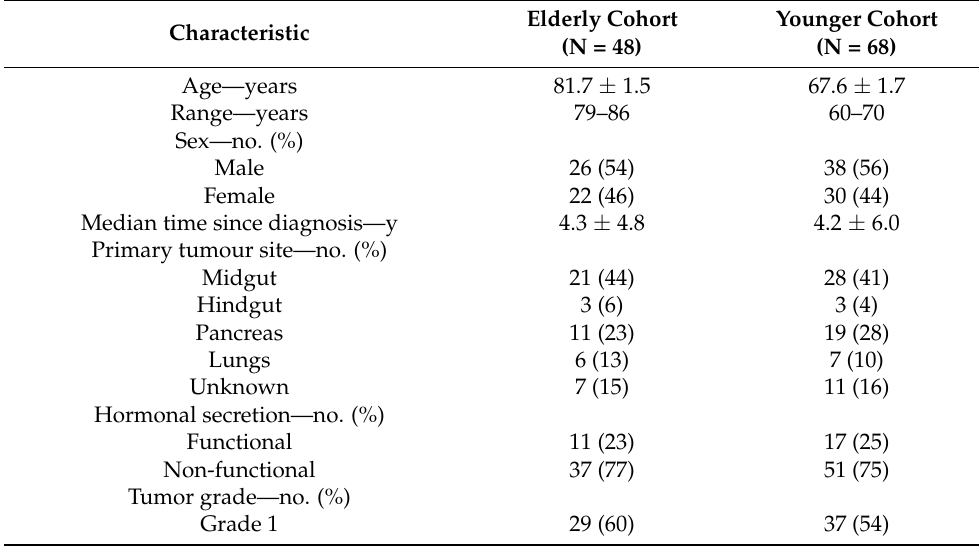
Table 1. Baseline patient demographics and clinical characteristics *.